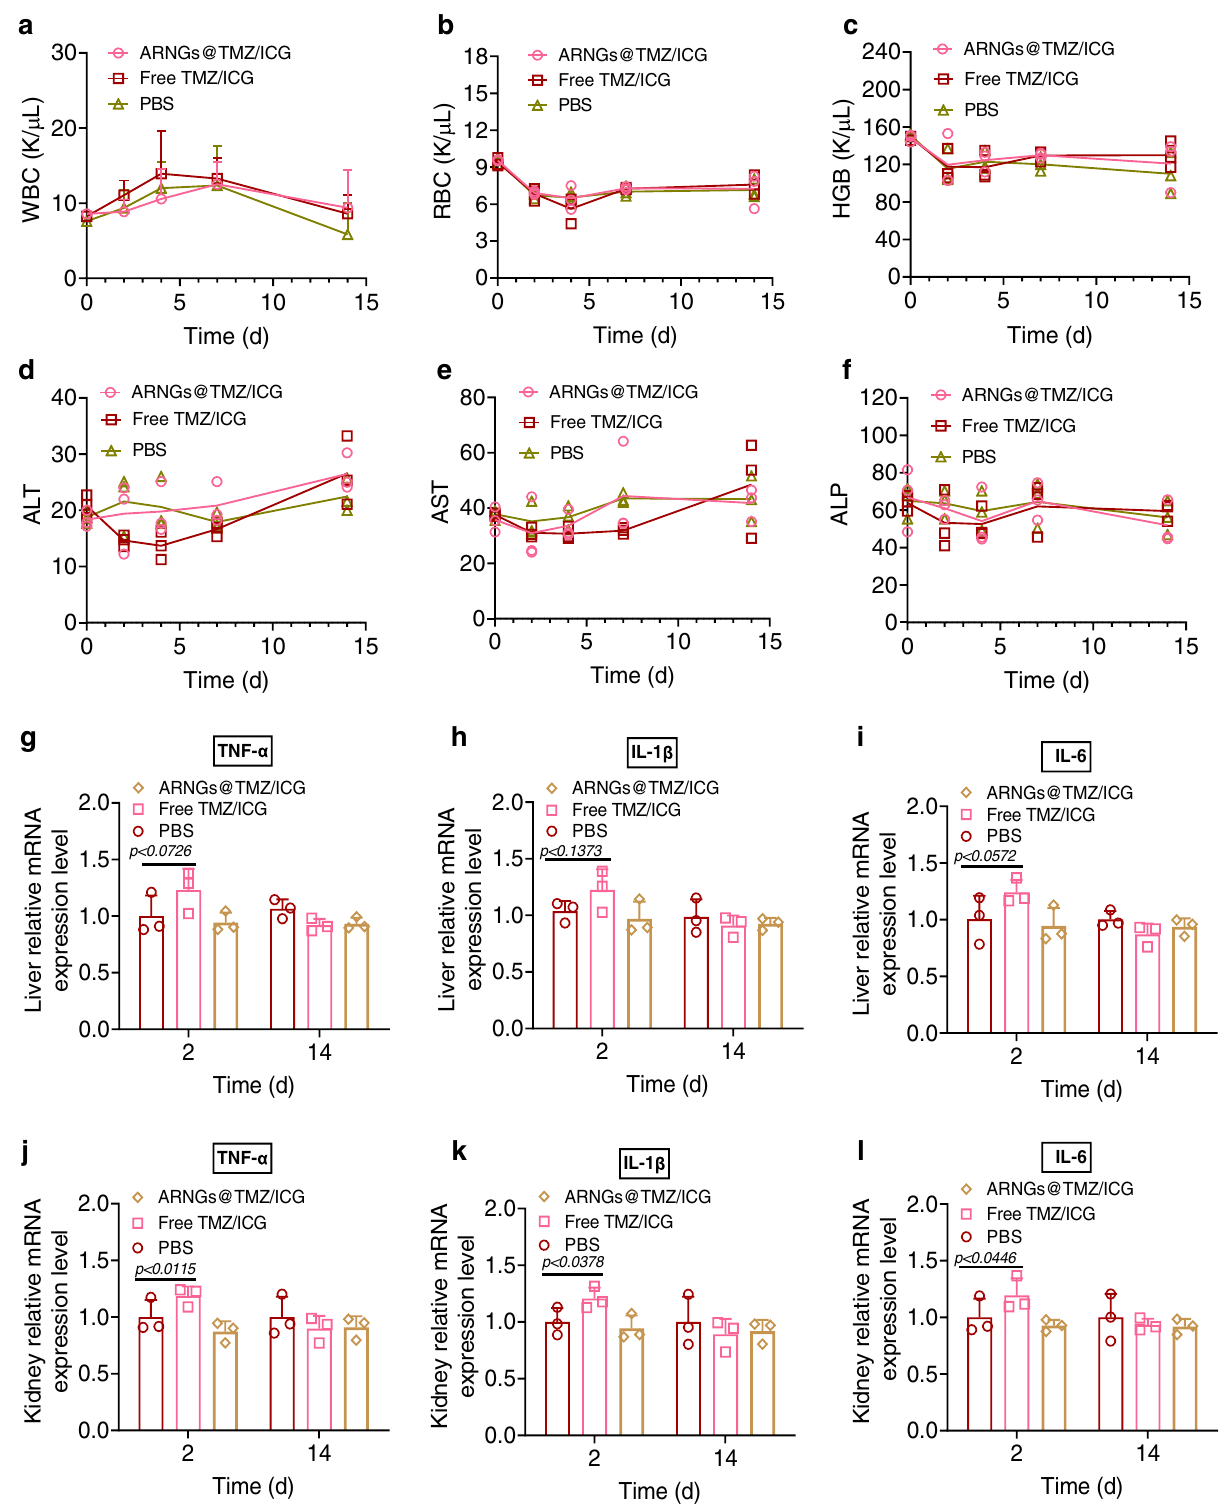
Fig. 8 | Biocompatibility evaluation of NIR-activatable ARNGs@TMZ/ICG. a – c Cytotoxicity and in vivo biocompatibility assessment of ARNGs@TMZ/ICG. White blood cell (WBC) ( a ), red blood cell (RBC) ( b ) and hemoglobin (HGB) ( c ) levelsinbloodsampleswereassessedafterasingledosetailveininjection.Dataare presented as mean±SD. d – f Blood chemistry examinations. Plasma alkaline phosphatase (ALP) ( d ), alanine aminotransferase (ALT) ( e ) and aspartate